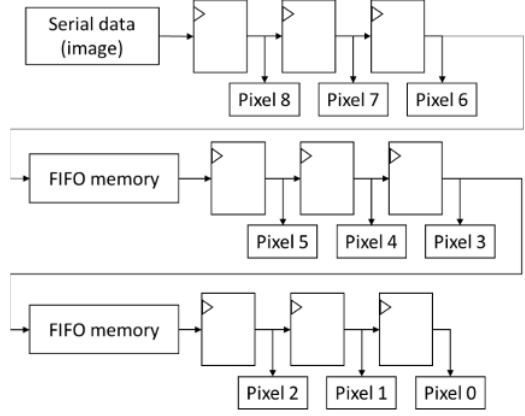
Fig. 5. Window generator architecture.